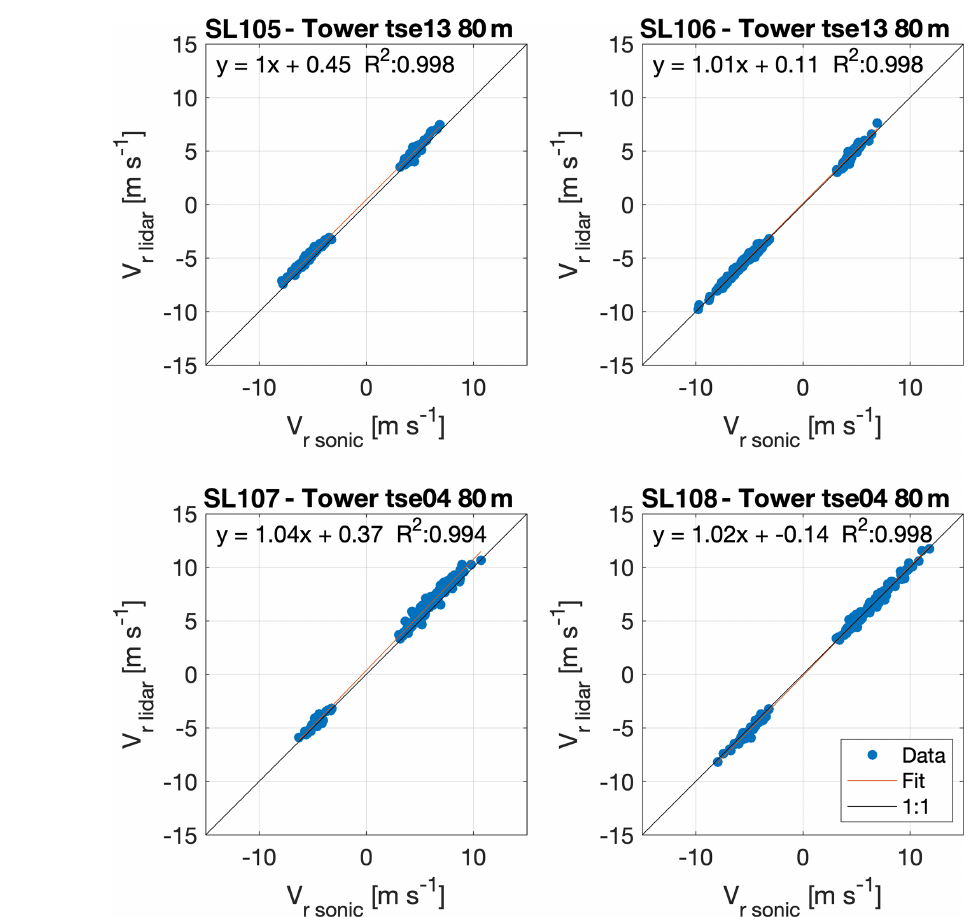
Figure 3. Correlation of radial lidar wind speeds with the sonic wind speeds projected to the lidar LOSs. Only southwesterly and northeasterly wind directions are selected for sectors of ± 15 ◦ , centered around the transect and oriented 54 ◦ towards